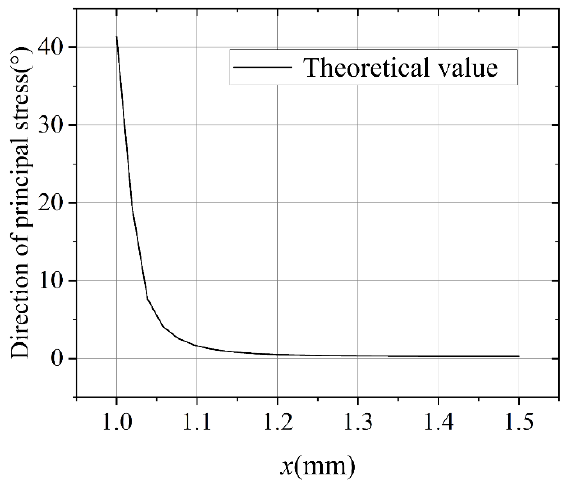
Figure 2. First principal stress distribution along the a-a section.